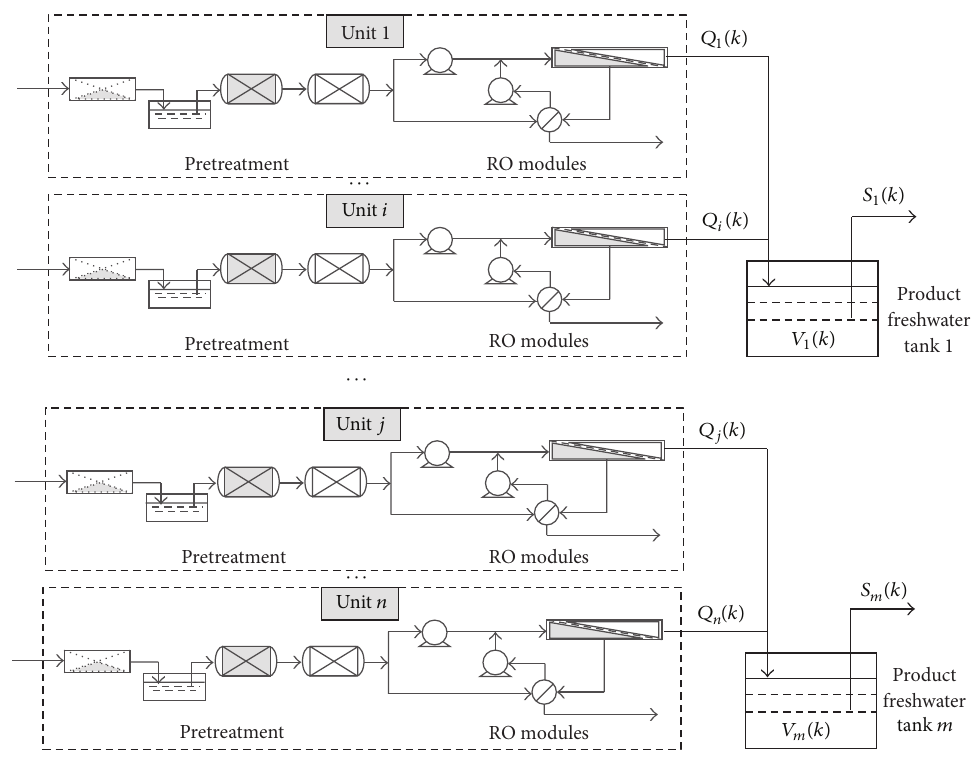
Figure 2: Schematic diagram of a parallel-unit SWRO desalination